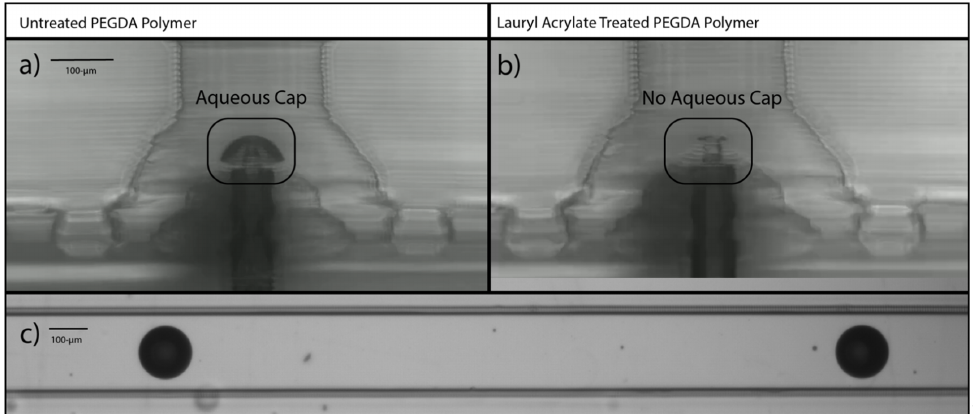
Figure 4. Before and after images of droplet generator. ( a ) Microphotograph of droplet generator made from PEG ‐ diacrylate with no surface treatment after several minutes of droplet generation, showing an aqueous phase in the form of a cap attached to the top of the pedestal. ( b ) Microphoto ‐ graph of droplet generator made from PEG ‐ diacrylate with three serial treatments of lauryl acrylate, showing no aqueous cap on the pedestal after several minutes of droplet generation. ( c ) Micropho ‐ tograph of droplets flowing in a serpentine channel, which droplets were formed in the MFD made with three serial treatments of lauryl acrylate.